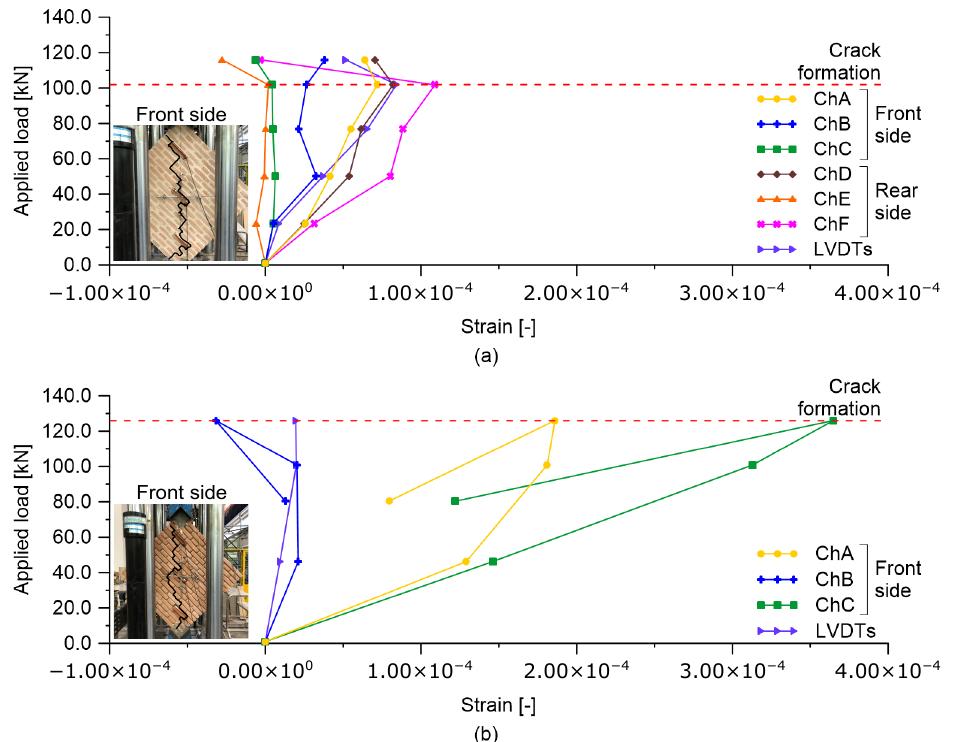
Figure 6. Trends of strain measured by smart bricks and LVDTs versus applied loads: ( a ) Specimen A with intact mortar layers; ( b ) Specimen B with degraded mortar